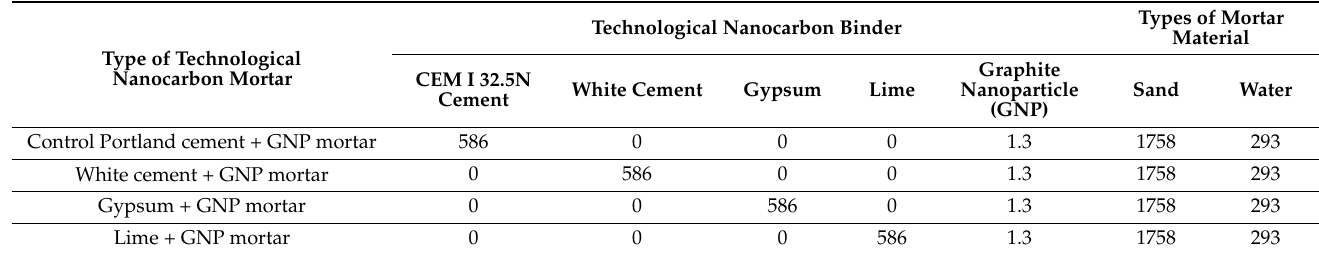
Table 2. Mixture proportions (kg/m 3 ) of advanced nanotechnological